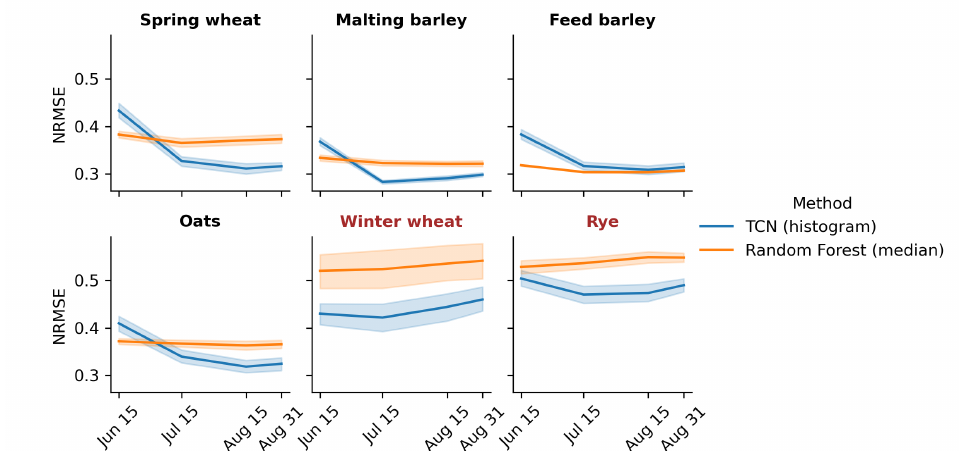
Figure 10. The normalized mean of root-mean-squared error (NRMSE), i.e., the share of root-mean- squared error from the mean crop-wise yield, and its 68% bootstrap confidence interval of farm-level predictions from four time steps within the growing season based on cloud-masked data.